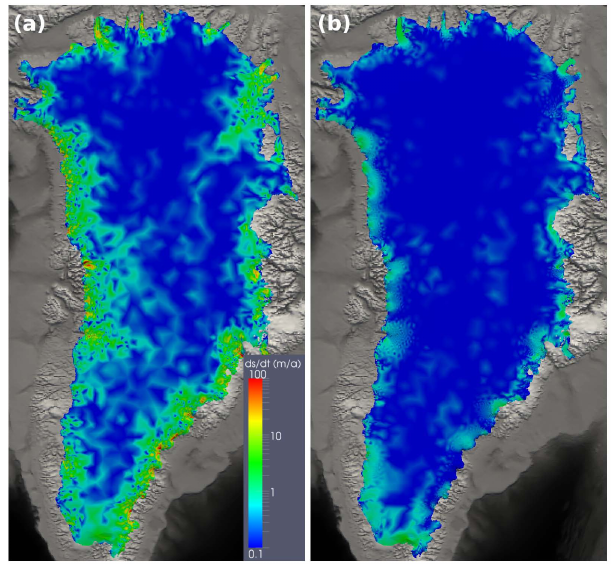
Fig. 6. Free surface elevation absolute rate of change: (a) after 1yr of relaxation; (b) after 50yr of relaxation.